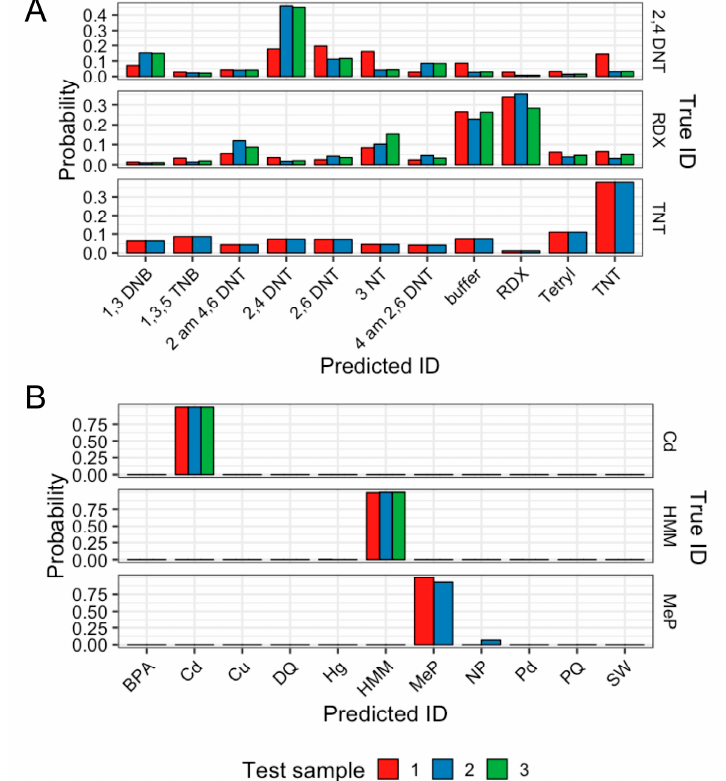
Figure 6. Evaluation of best model on a new experimental dataset of explosives samples or holdout seawater data. ( A ) Eight scans from three random classes were held out from training and tested for a final evaluation. Evaluated using ALSTM-FCN, the best performing model for classification of seawater with 11 classes. Eight out of eight samples were correctly classified ( B ) Scans from each compound (10 µg) wiped off benchtop. Evaluated using LSTM, the best performing model for classification of explosives with 11 classes. Seven out of eight samples were classified correctly, with Sample #1 of 2,4 DNT classified as 2,6 DNT.